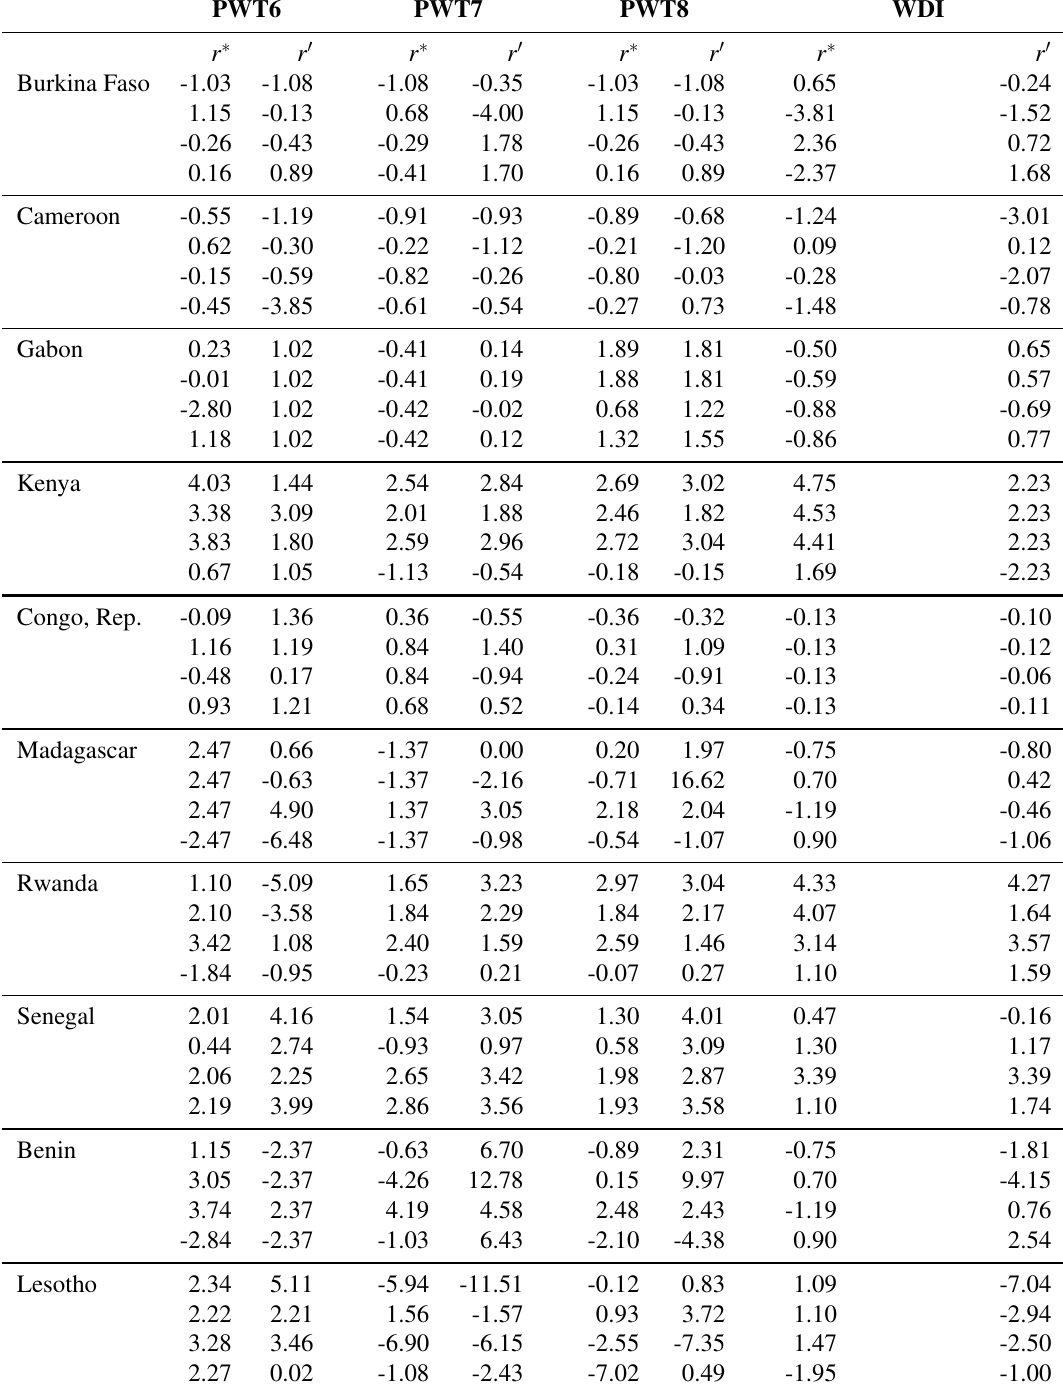
Table 12: t -ratios of the best and second best choice of rank PWT6 PWT7 PWT8